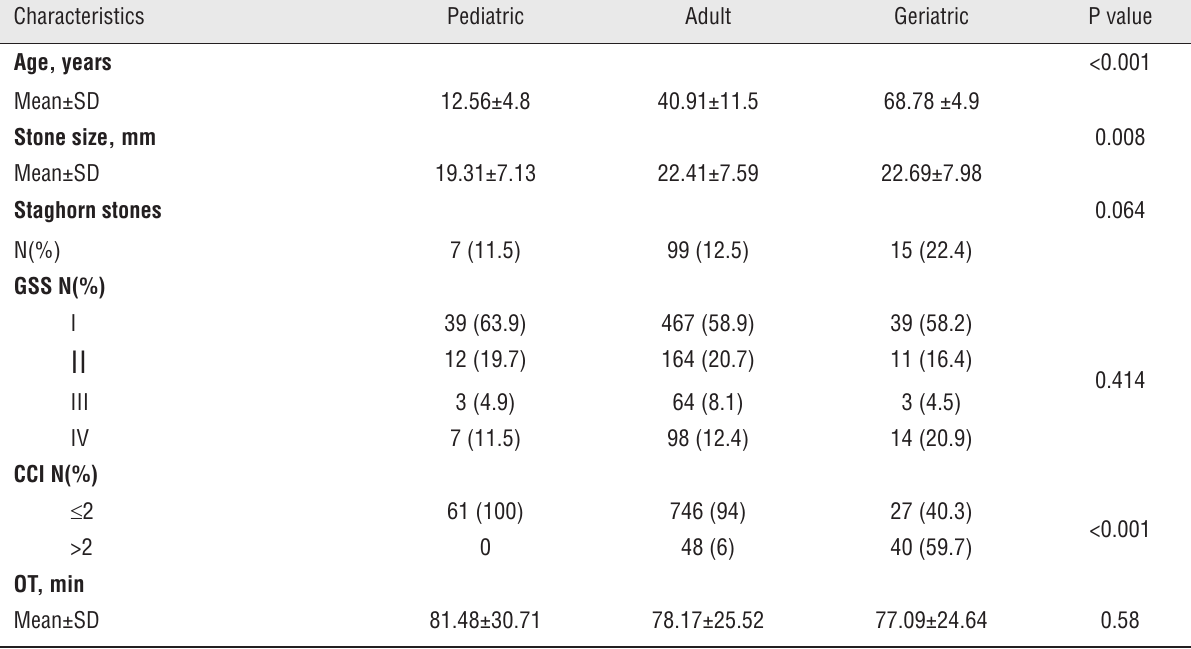
Table 1 - patient, stone characteristics and OT based on age groups. Characteristics